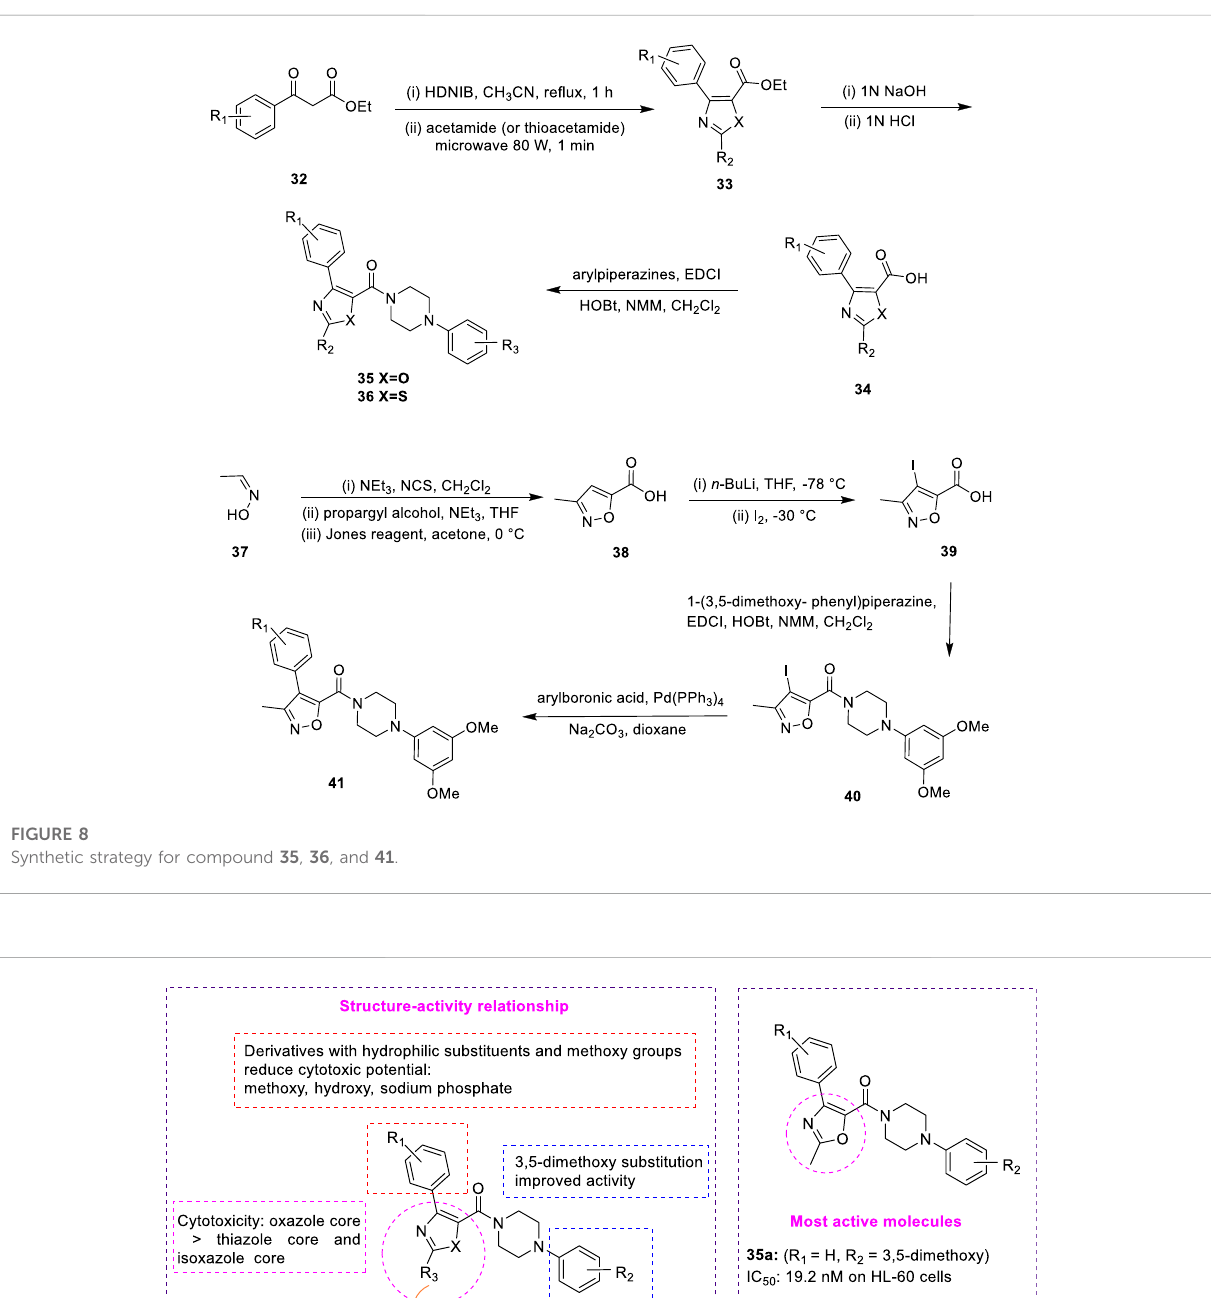
FIGURE 9 SAR and active molecules of aryloxazole